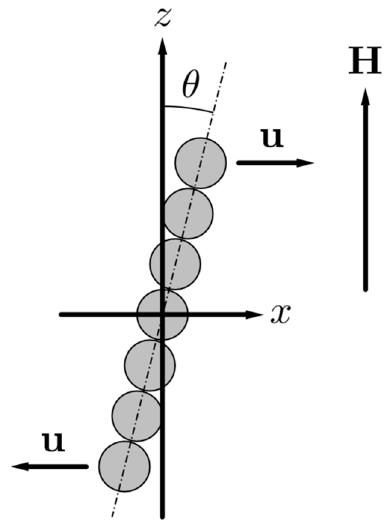
Figure 2. Illustration of the shearing of the chain.